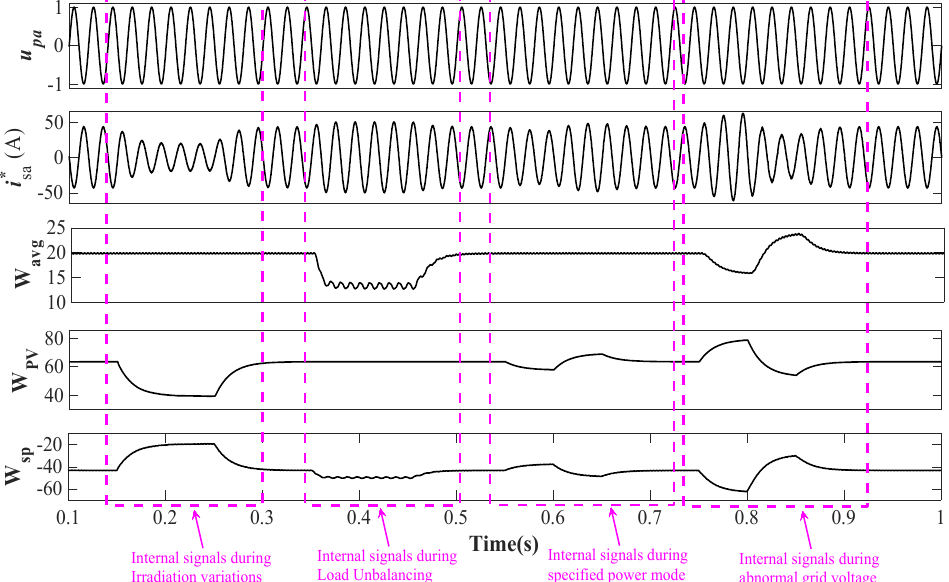
, W avg , W PV , and W sp . Figure 15. Internal control signal analysis of 𝜇 (cid:3043)(cid:3028) , 𝑖 (cid:3020)(cid:3028)∗ , W (cid:2911)(cid:2932)(cid:2917) , W (cid:2900)(cid:2906) , and W (cid:2929)(cid:2926) . Sa